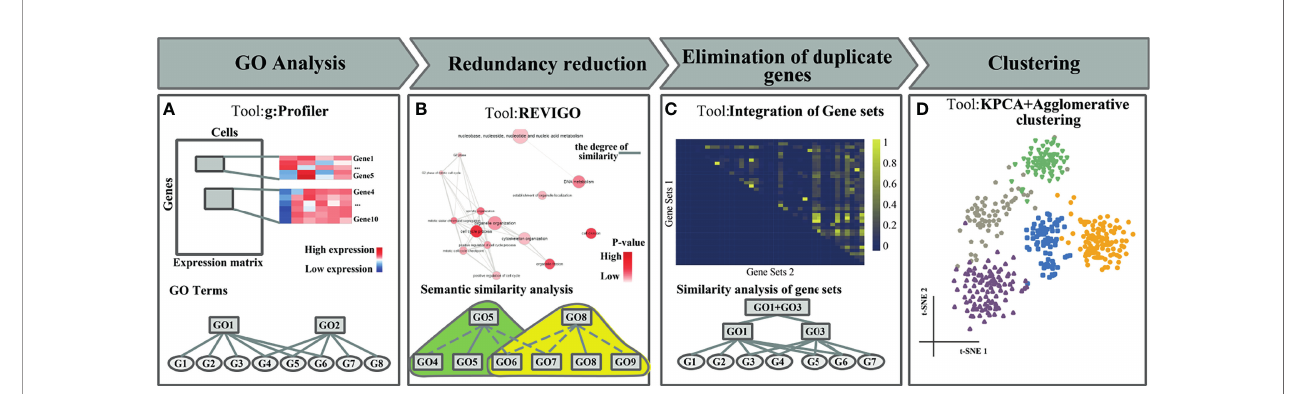
FIGURE 1 | The fl owchart of FEGFS + clustering. (A) Gene Ontology (GO) analysis. (B) Redundancy reduction. (C) Elimination of duplicate genes. (D) Feature extraction and clustering